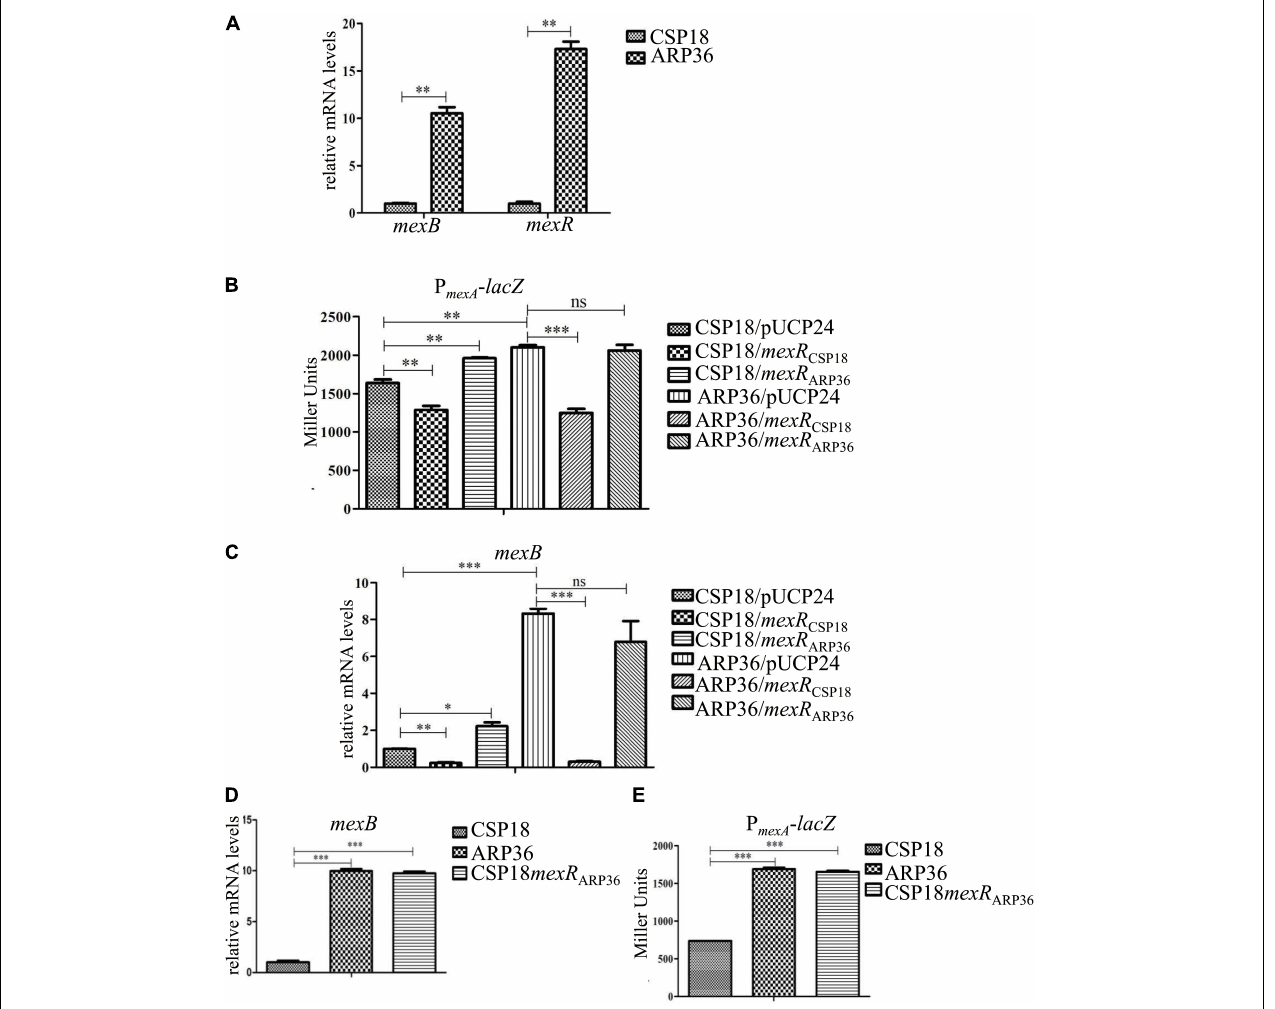
FIGURE 2 | Transcriptional levels of indicated genes in indicated strains. (A) Relative mRNA levels of mexB (A , C , D) and mexR (A) in indicated strains. Total RNA was isolated from indicated strains at OD 600 of 1.0, and the relative mRNA levels of indicated genes were examined by real-time qPCR with rpsL as an internal control. (B,E) β -galactosidase assay was carried out to examine the transcriptional activity of mexAB-oprM operon promoter fused with a lacZ gene in indicated strains. ns, not significant; * P < 0.05; ** P < 0.01; *** P < 0.001, by Student’s t -test.